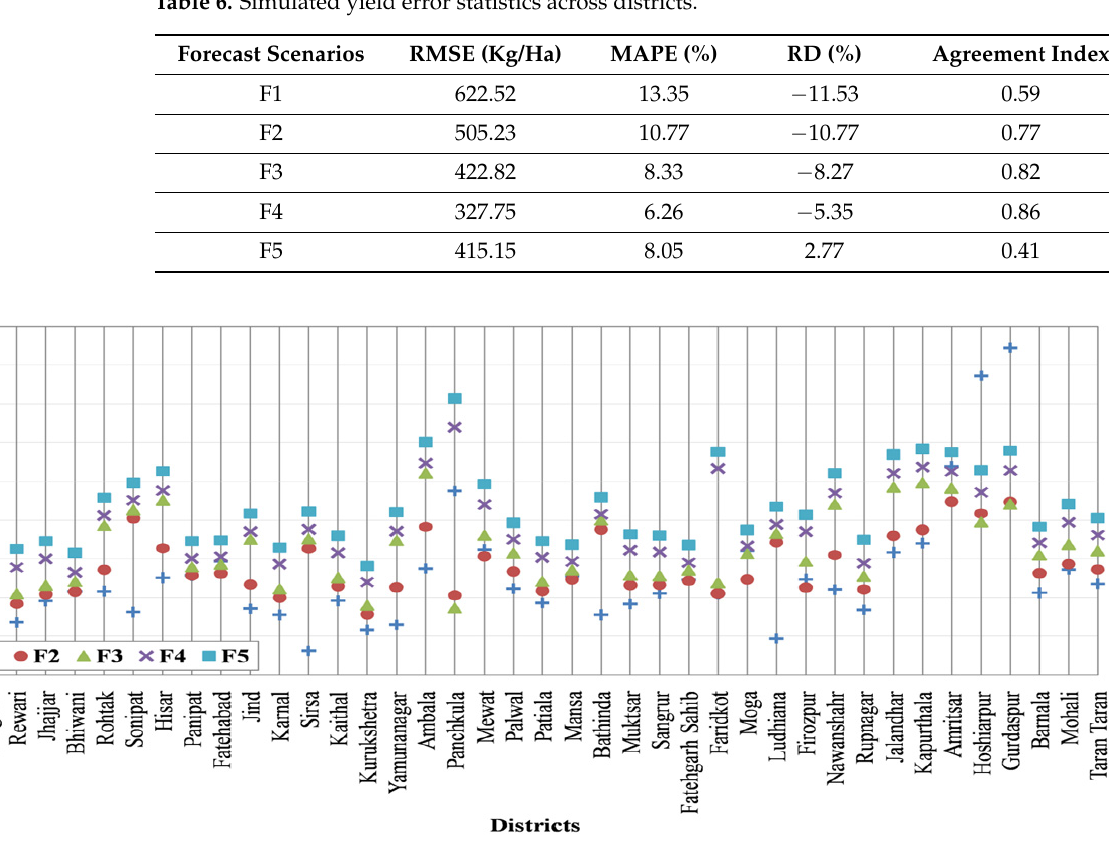
Figure 5. Relative deviation plot across districts for different forecast scenarios.